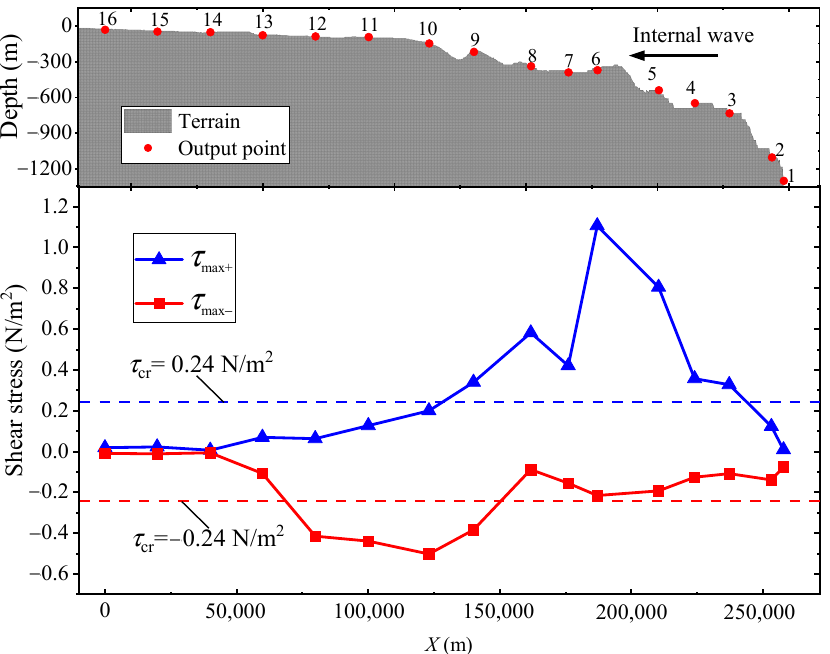
Figure 10. Maximum shear stress on cross-section P1 during the propagation of internal waves on the continental slope of the northern SCS.